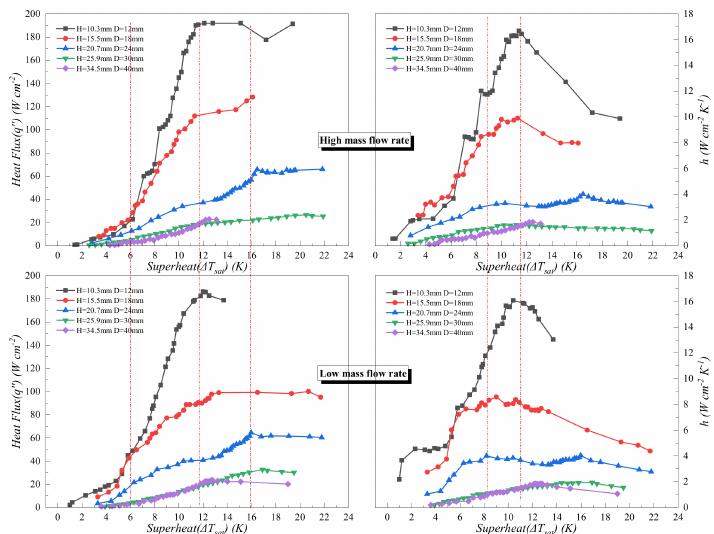
Figure 6. Heat flux and heat transfer coefficient versus superheat at complete